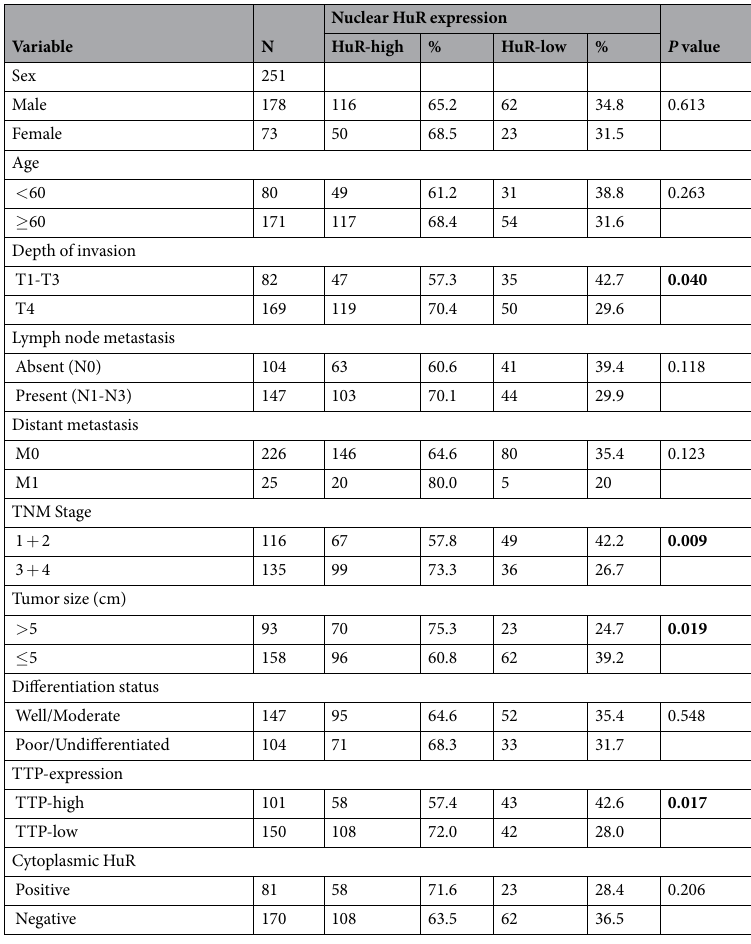
Table 3. The correlations between nuclear HuR expression and the clinical features of GC patients. P value < 0.05 was indicated in